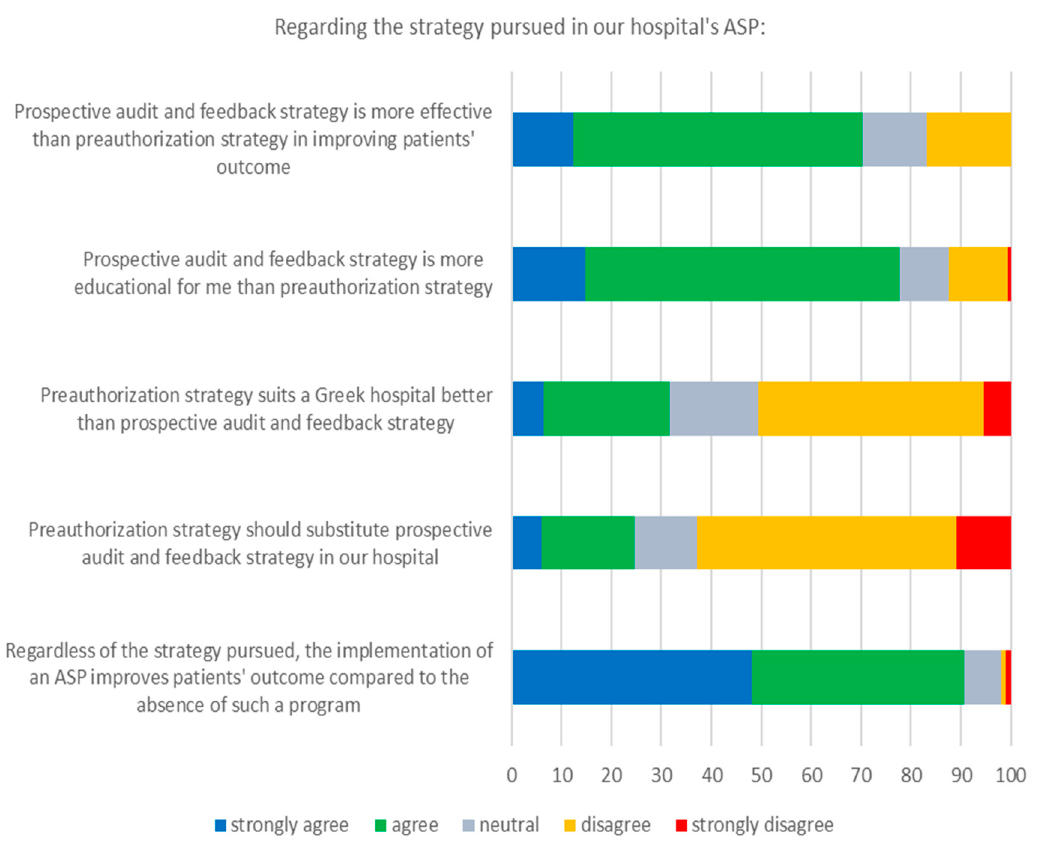
Figure 1. Respondents’ perceptions regarding the strategy pursued in our hospital’s ASP.